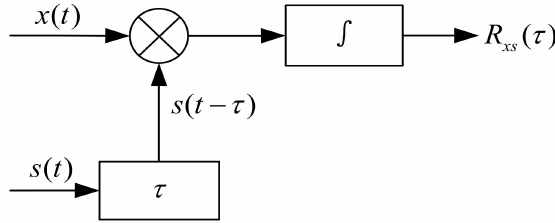
Figure 3. Correlation machine receiving